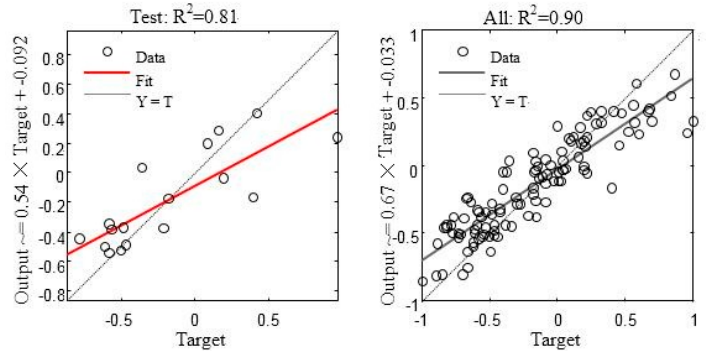
Figure 14. Fitting of the BP neural network to the TP effluent concentrations.